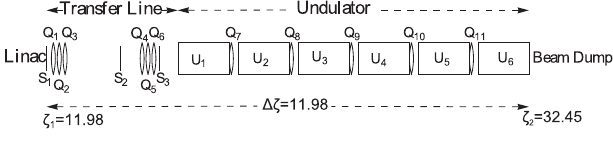
FIG. 1. Layout of the SPARC transfer line (quads Q 1 → Q 6 ) and undulator line (undulator sections U 1 → U 6 and quads Q 7 → Q 12 ). The S ’ s tag the positions of the imaging screens, the ζ ’ s measure the distance from the photocathode.